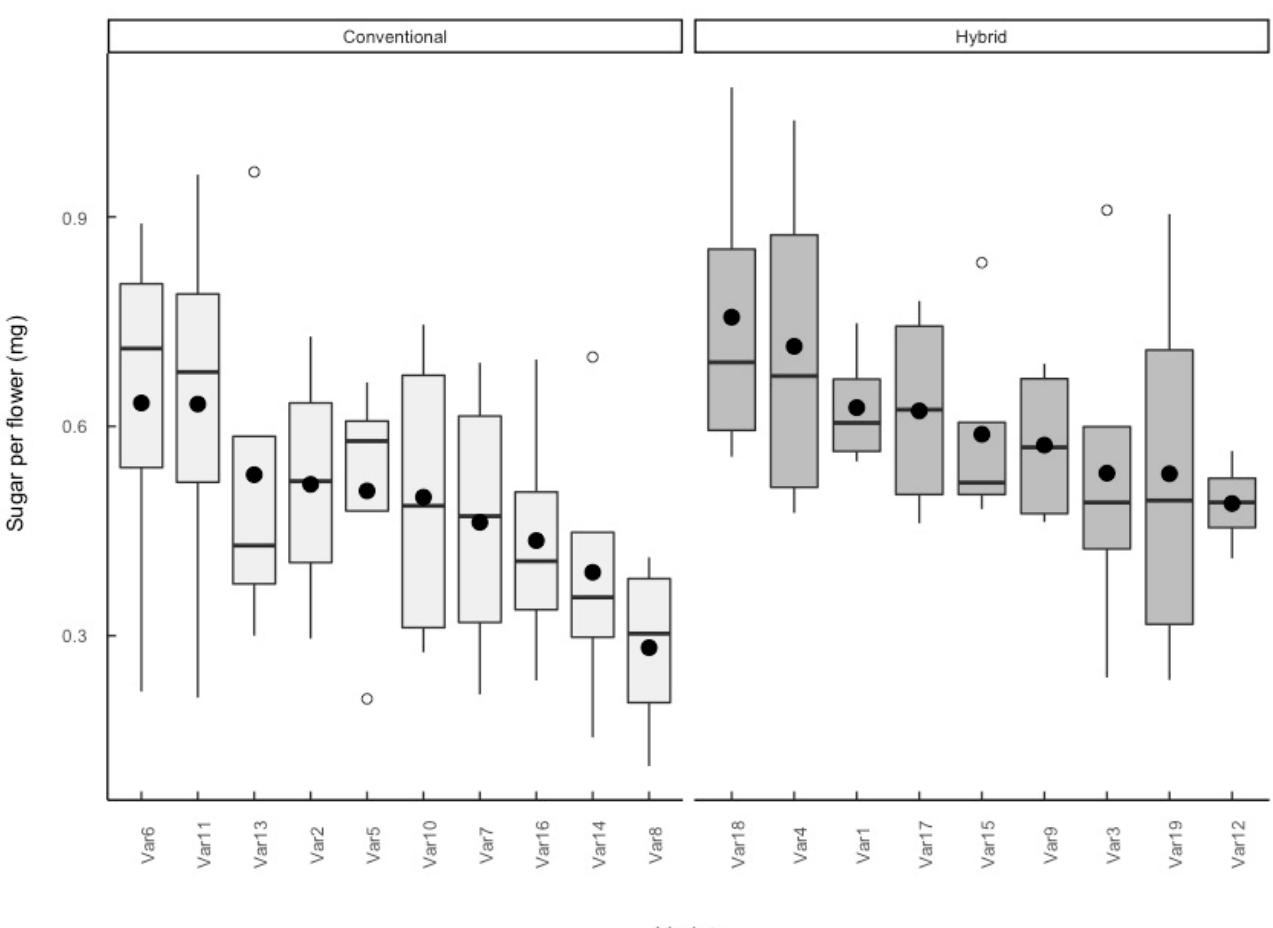
Figure 2. The quantity of sugar per flower in 19 oilseed rape varieties (n = 20 flowers). Black circles represent the mean values. Boxes around the median show the interquartile range. Whiskers extend to minimum and maximum values. Variety names have been anonymised by request.